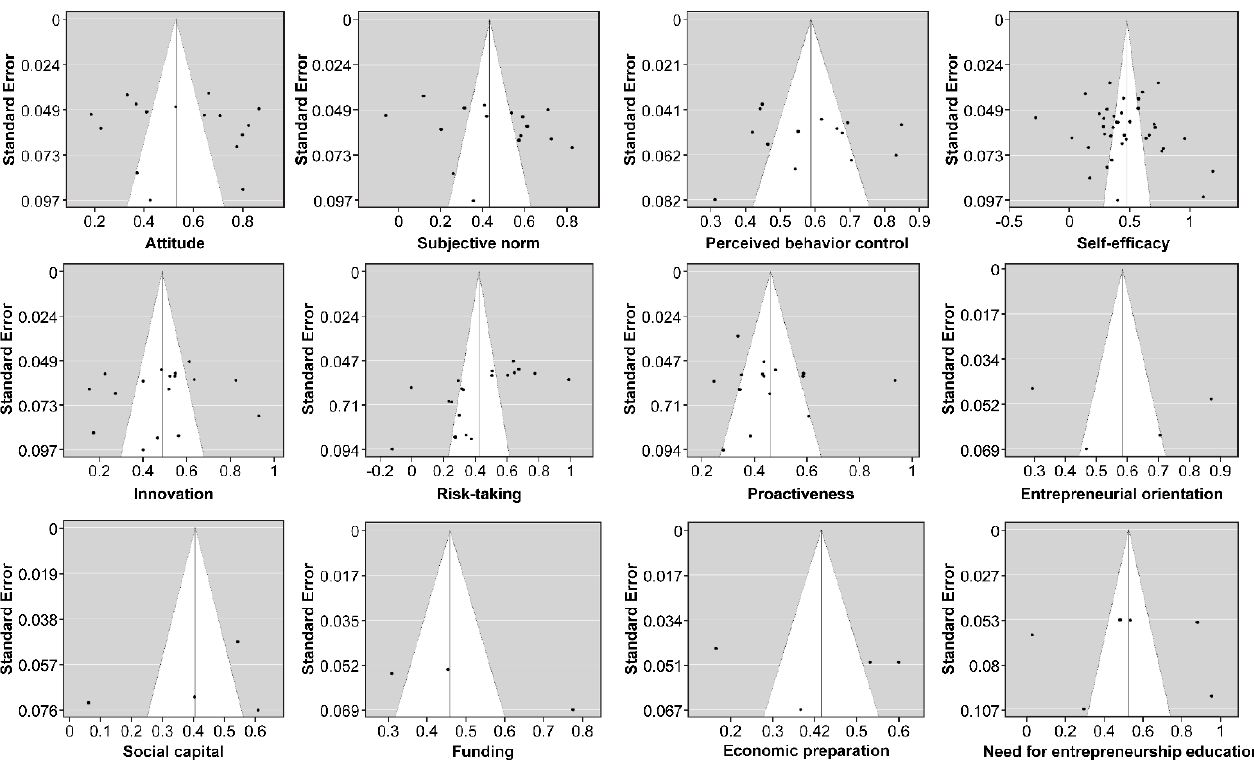
Table 1. Summary of meta correlation analysis.